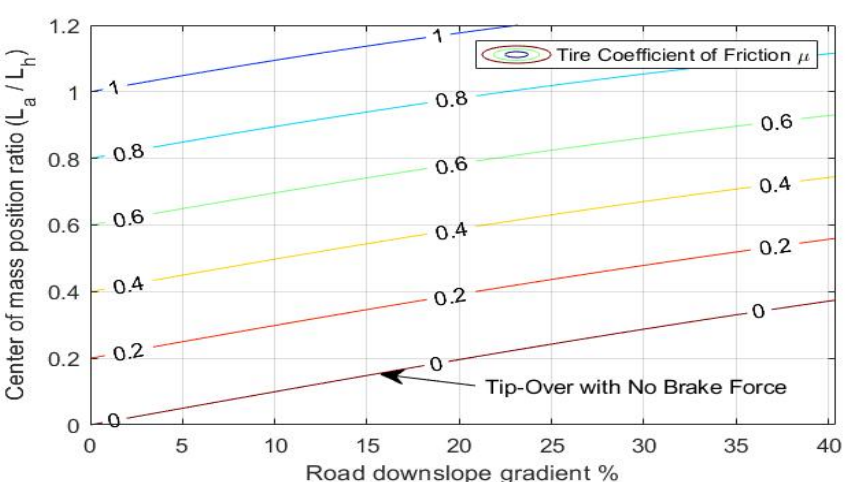
Figure 11. Critical tire coefficient of friction at tip-over for the varying center of mass positions and road gradients defining the region at which tip-over may occur. Tire coefficient of friction is shown by the colored lines, with values increasing with the color gradient from red to blue.